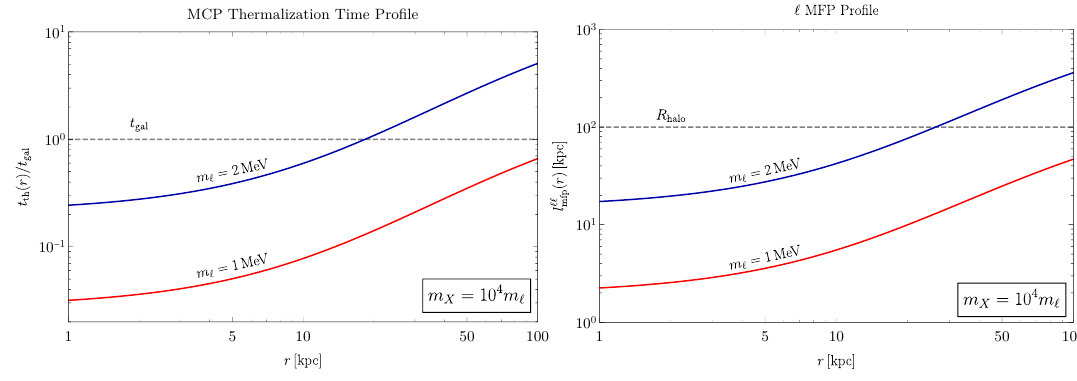
Figure 2 . The thermalization timescale t th (left) and the ‘ mfp l ‘‘ halo radius r . t th is normalized by the galaxy age t gal , and l ‘‘